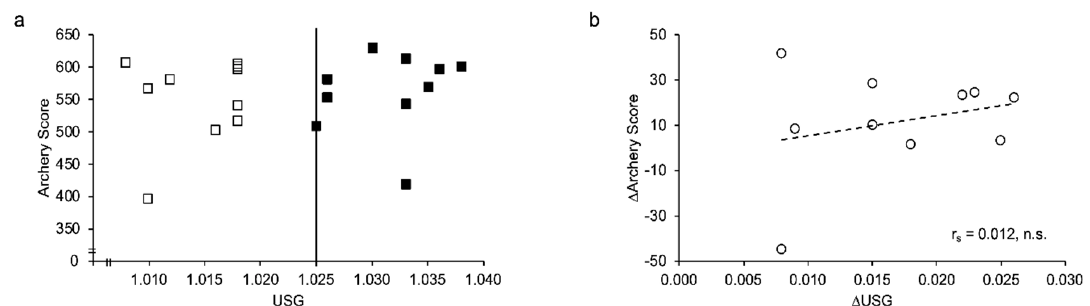
Figure 2. Archery Performance in relation to Urine Specific Gravity (USG) values. Panel ( a ) depicts both archery scores for EUH trial (open squares) and DEH trial (dark squares). Panel ( b ) depicts the correlation between ∆ USG (USG DEH -USG EUH ) and ∆ Archery score (Archery Score DEH –Archery Score EUH ). No significant correlation was found between USG and Archery Performance.